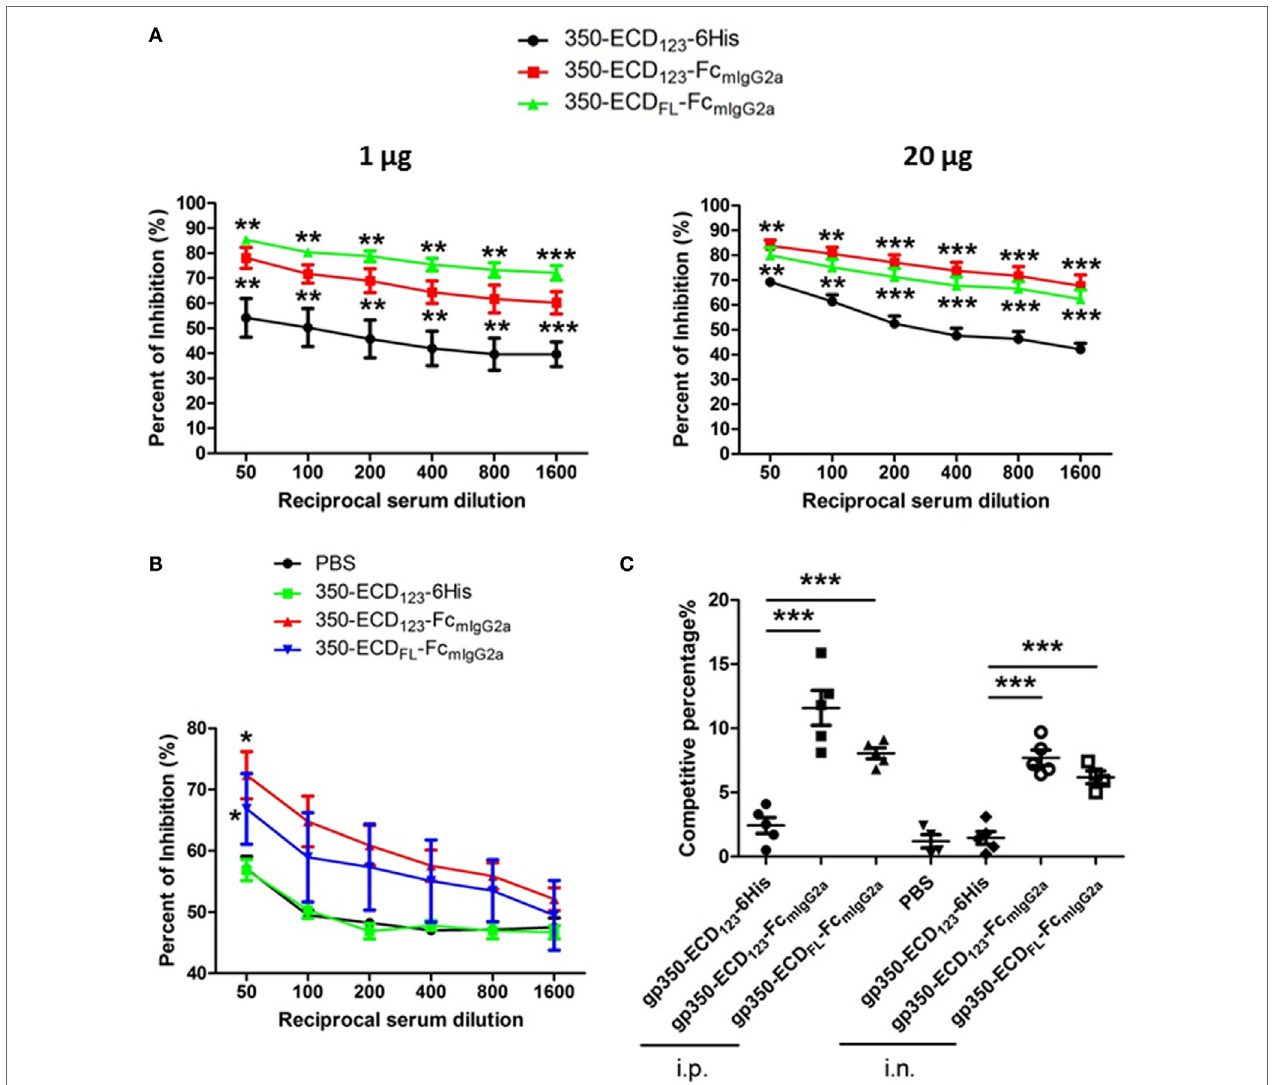
FigUre 4 | Immunization with Fc-based recombinant gp350 proteins elicits dramatically higher neutralizing titers than monomers. (a) Competition enzyme-linked immunosorbent assay (ELISA). BALB/c mice (five per group) were immunized i.p. with 1 µg (left panel) or 20 µg (right panel) of the indicated proteins in Alum adjuvant. Serum dilutions were used to block binding of neutralizing monoclonal antibody mAb72A1 to monomeric gp350 in competition ELISA. Percentage of inhibition of mAb72A1 binding is reported. (B) Competition ELISA. BALB/c mice (five per group) were immunized i.n. with 20 µg proteins assisted by CpG. Sera were analyzed for the ability to block mAb72A1 as in panel (a) . Each data point represents mean ± SEM ( n = 5). (c) Competition by surface plasmon resonance (SPR). Neutralizing mAb72A1 was used to compete binding of serum immunoglobulin from mouse immunized with the indicated antigens to immobilized monomeric gp350 by SPR. The percentage of reduction of serum Ig binding is indicated. Each symbol represents the serum of one mouse (five mice per group), and the bars show mean ± SEM values. Significance (* p ≤ 0.05, ** p < 0.01, and *** p < 0.001) between Fc fusion proteins versus monomer gp350 proteins is